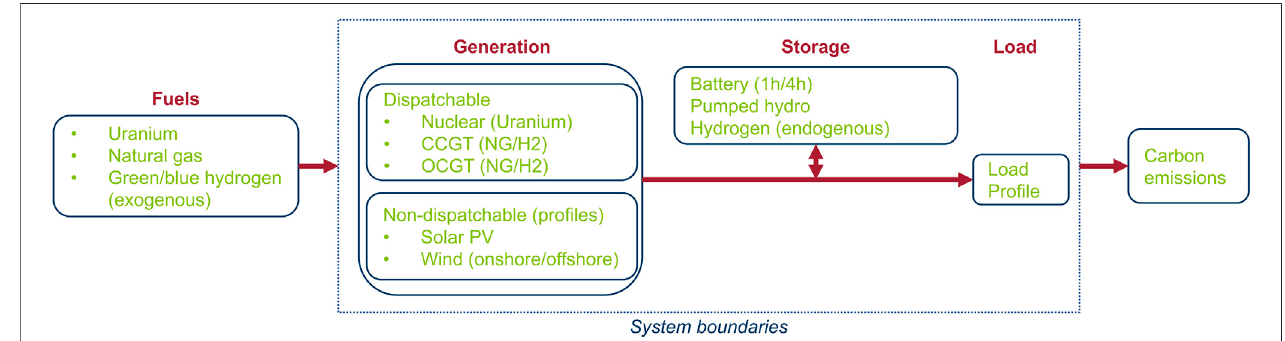
FIGURE 1 | Model structure and system